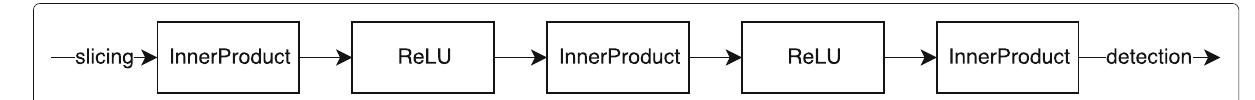
Fig. 6 Structure of “Detection” implemented in our experiment. Legends can be referred to Fig. 1. All built-in layer names conform to Caffe. Details can be referred to Section 4.1